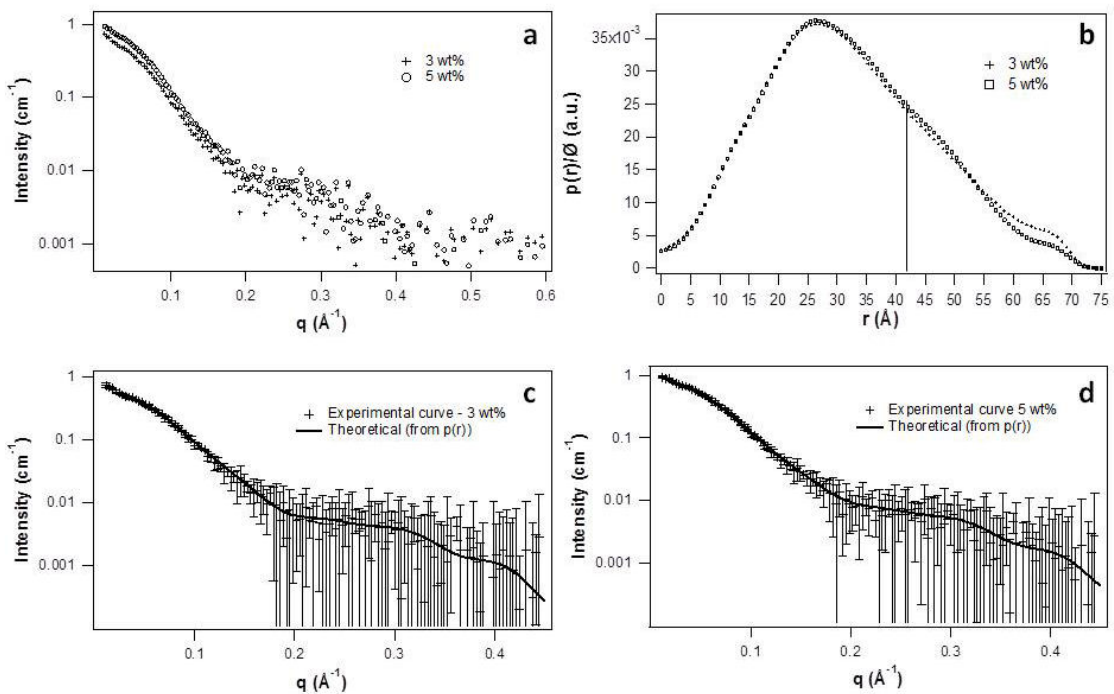
Figure 3. ( a ) SAXS curves; ( b ) Distance distribution function of QS in aqueous solution at 3 and 5 wt%; Theoretical intensity, calculated from the p(r) functions, together with the experimental curve for ( c ) 3 wt% and ( d ) 5